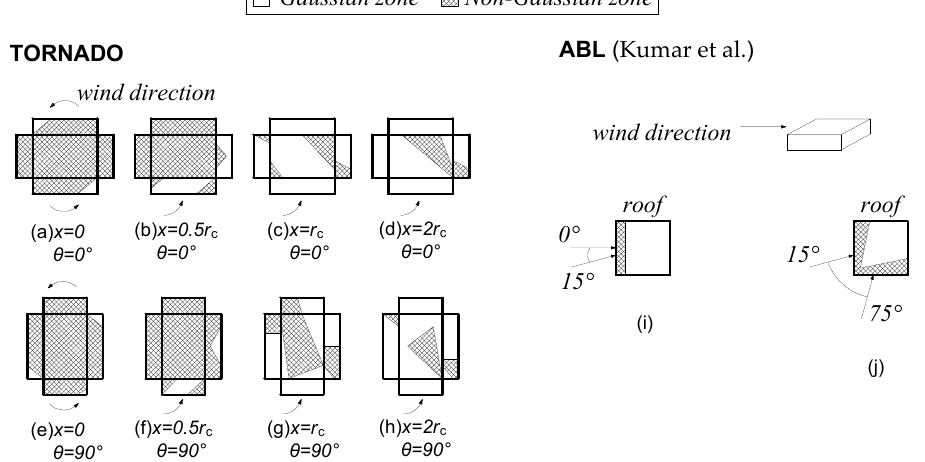
Figure 8. Gaussian and non-Gaussian zones for flat roof buildings in two types of wind fields. ( a ) x = 0, θ = 0 ◦ ; ( b ) x = 0.5 r c , θ = 0 ◦ ; ( c ) x = r c , θ = 0 ◦ ; ( d ) x = 2 r c , θ = 0 ◦ ; ( e ) x = 0, θ = 90 ◦ ; ( f ) x = 0.5 r c , θ = 90 ◦ ; ( g ) x = r c , θ = 90 ◦ ; ( h ) x = 2 r c , θ = 90 ◦ ; ( i ) wind direction from 0 ◦ to 15 ◦ ; and ( j ) wind direction from 15 ◦ to 75 ◦